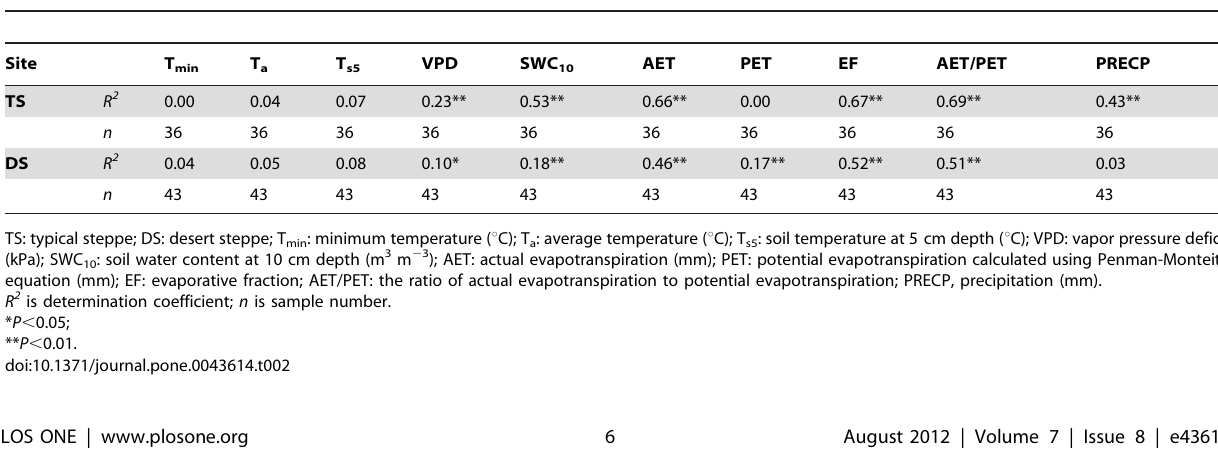
Table 2. Pearson correlation analysis between 8-day averages or sums of LUE and environmental factors at each site.